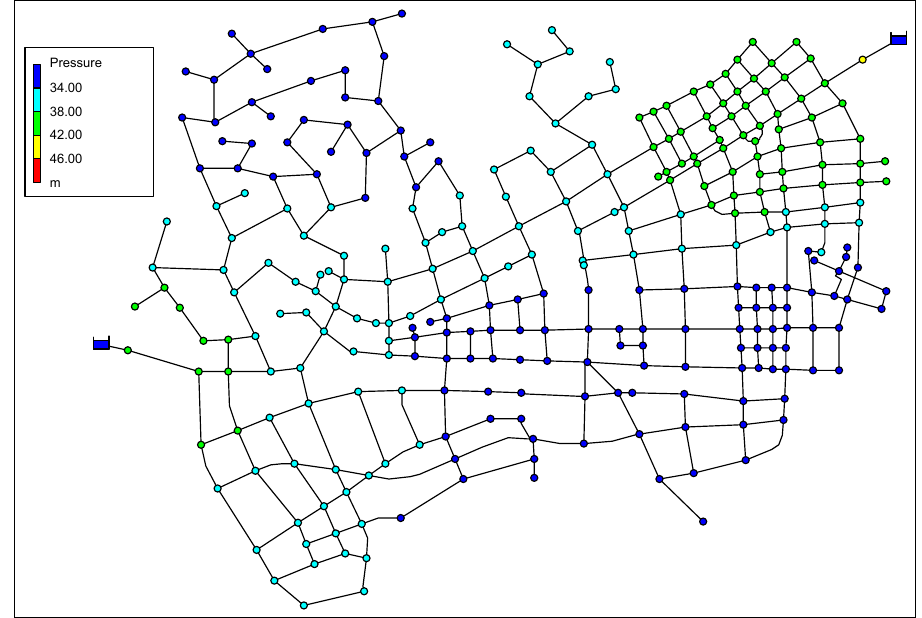
Figure 4. Topology and nodal mean pressure of JYN